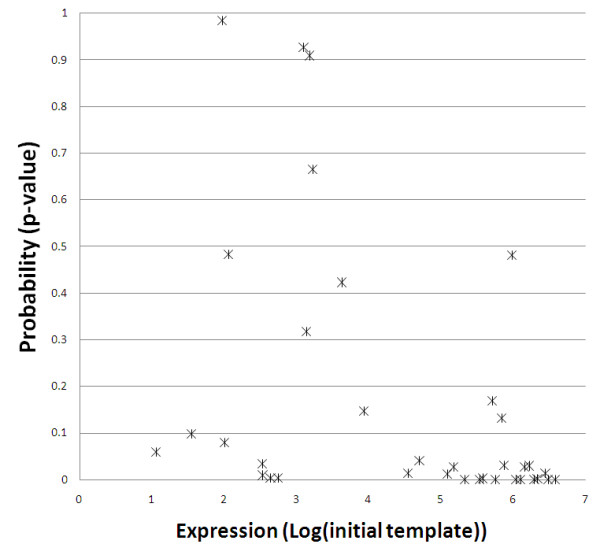
Comparision between the predicted effects of miRNAs and their expression as determined by RT-PCR. The estimated copy number (Log(initial template)) of each miRNA in a given sample is plotted against the probability (Wilcoxon ranked sum test) that it is having an effect upon target gene expression. The most highly expressed miRNAs have very significant effects upon predicted target gene expression and the overall correlation between miRNA expression and significance of effect upon target gene expression is significant (p = 4.0E-04; Spearman rank correlation).